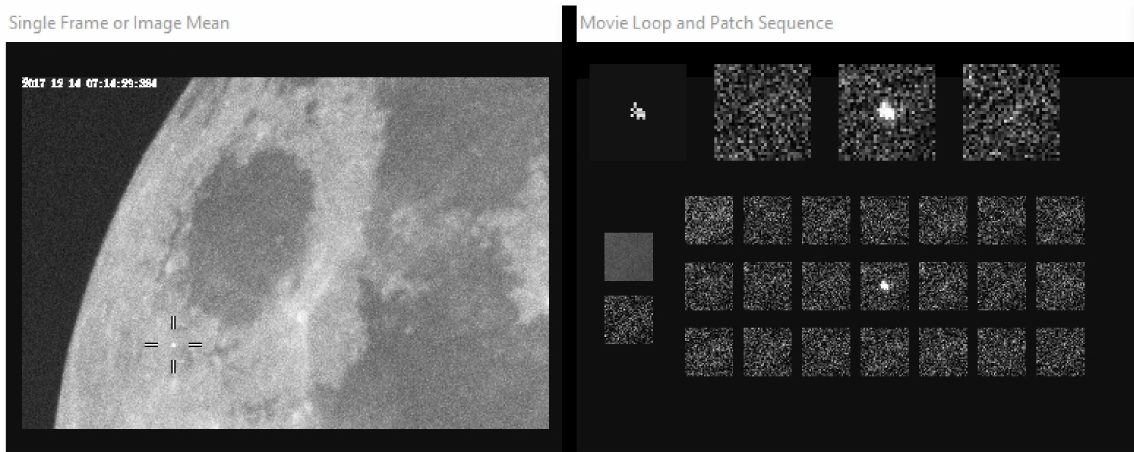
Figure 2. LunarScan windows displaying Flash 1 from the Macei ó recording.